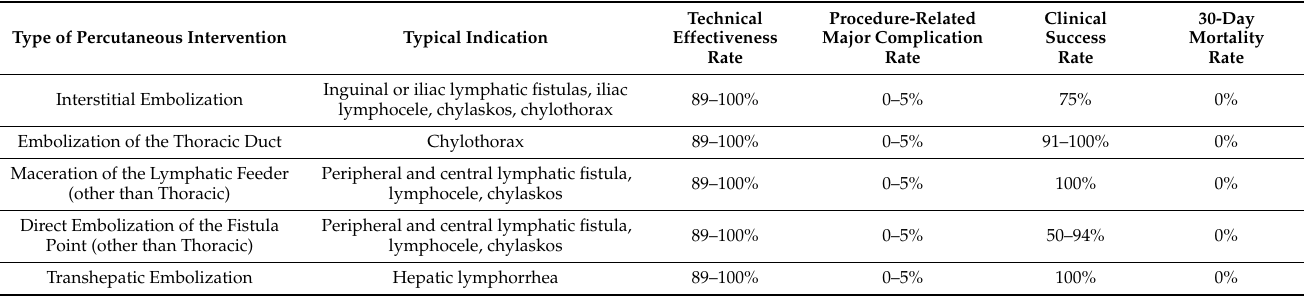
Table 1. Brief overview of image-guided percutaneous interventions for lymphatic